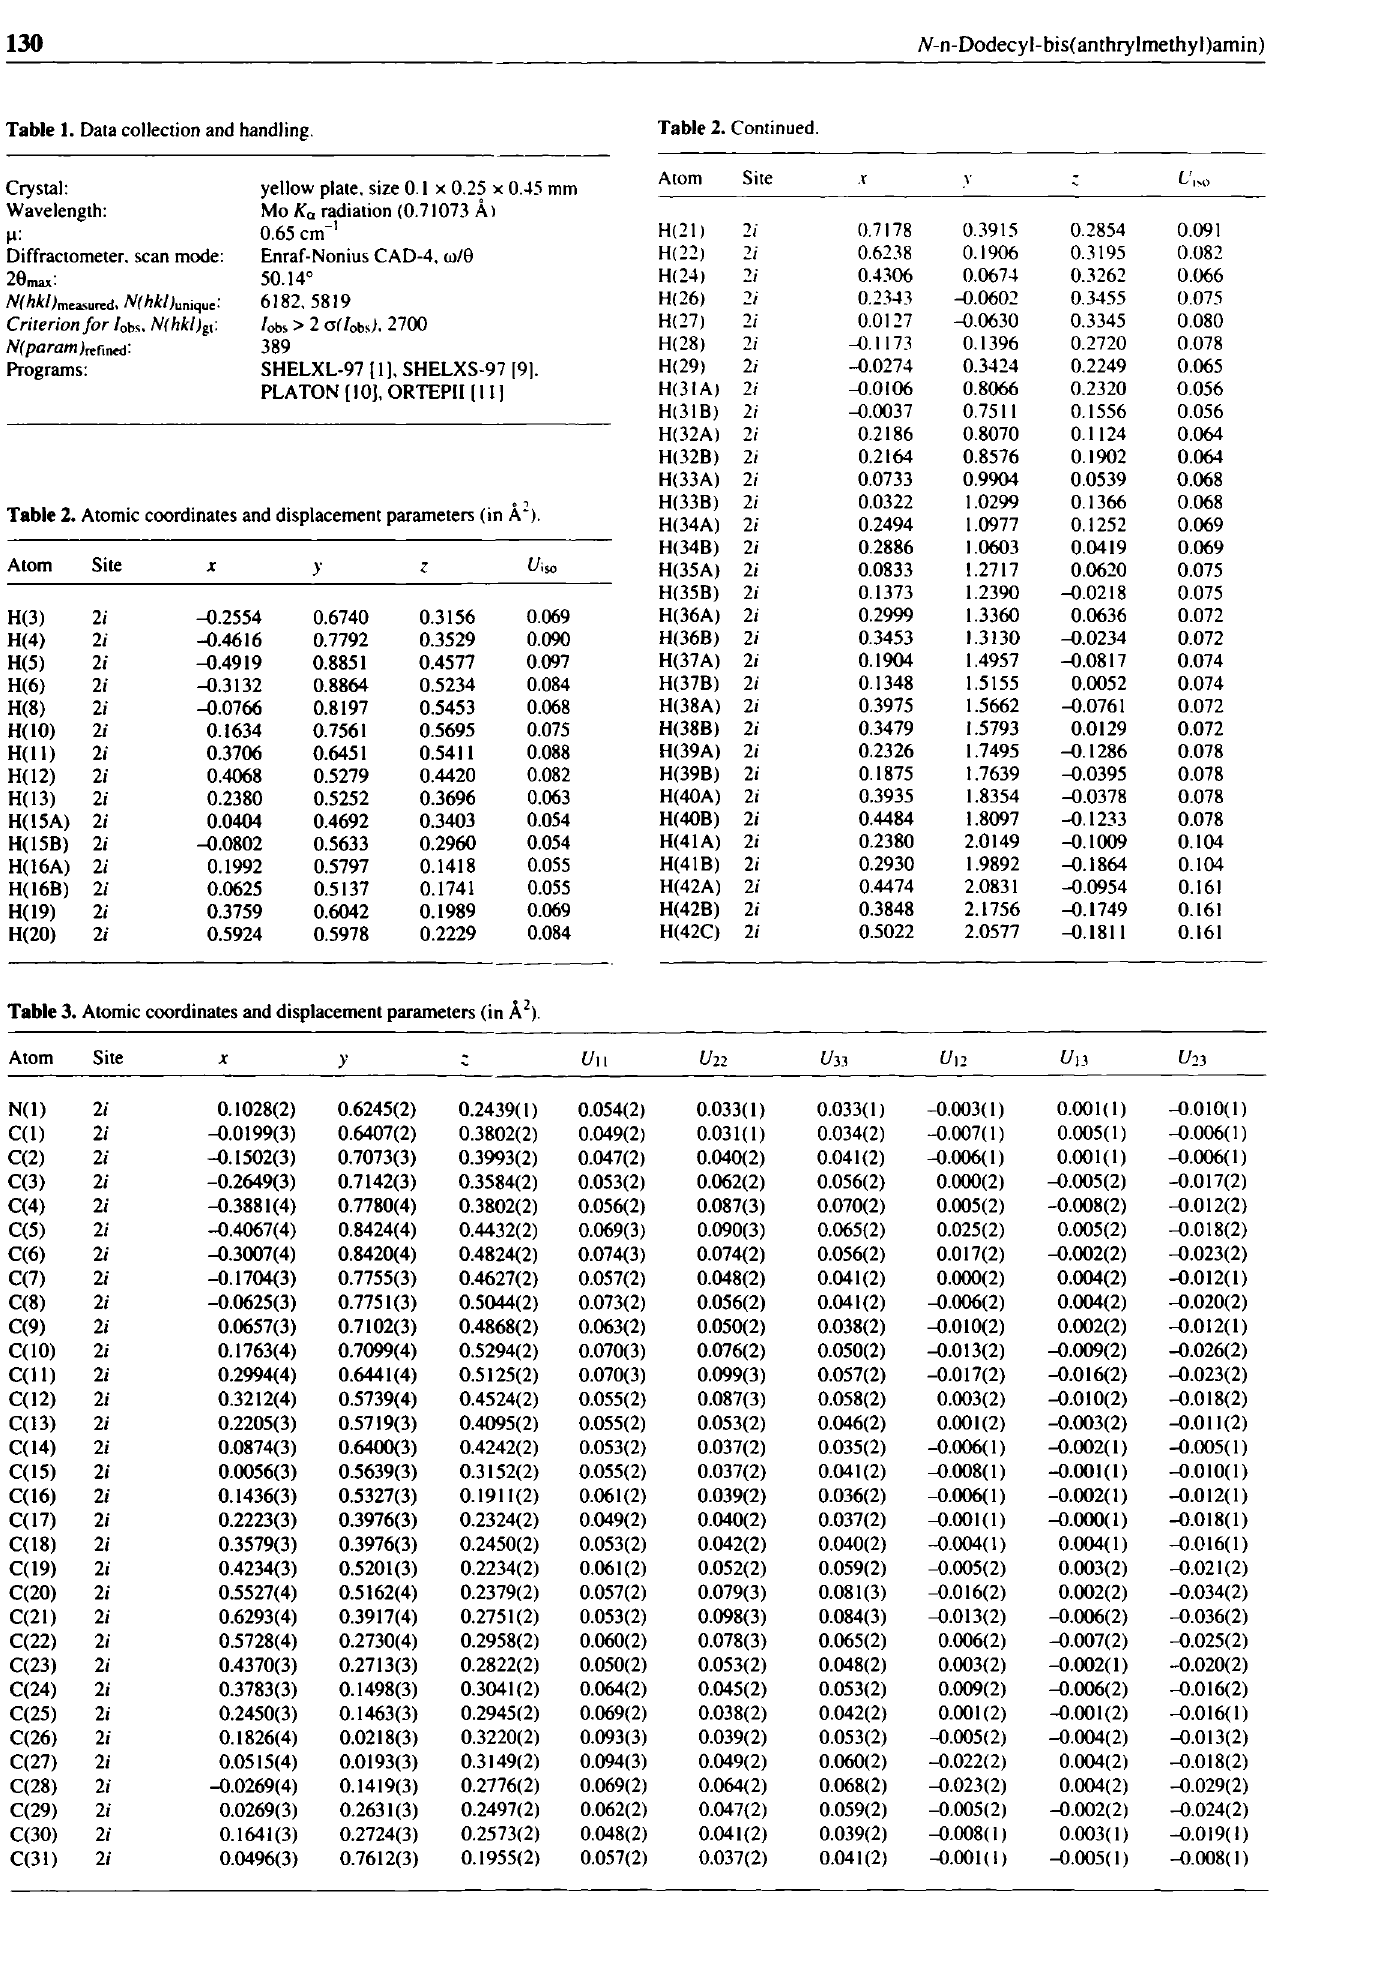
Table 3. Atomic coordinates and displacement parameters (in Ä 2